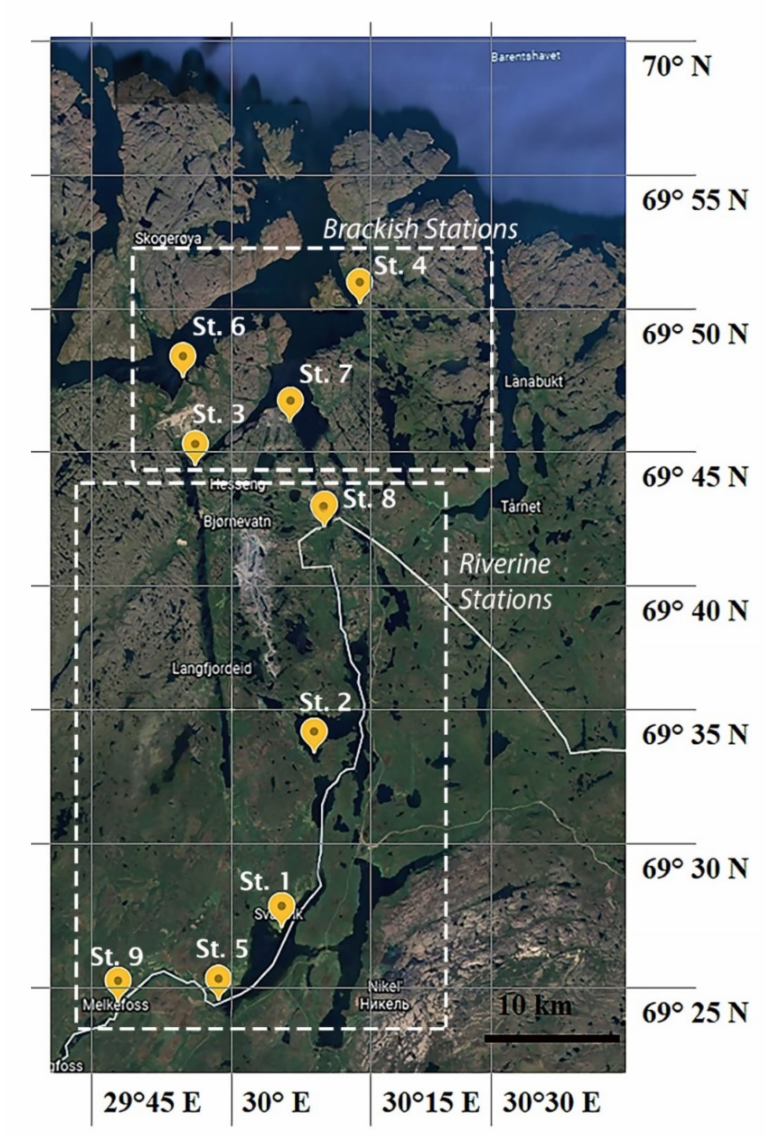
Figure 1. Location of the sampling stations along the Pasvik